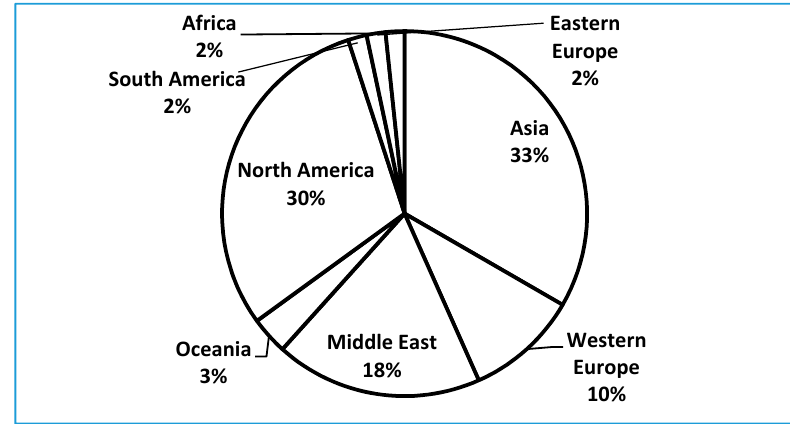
Figure 3. Regional distribution of empirical data.